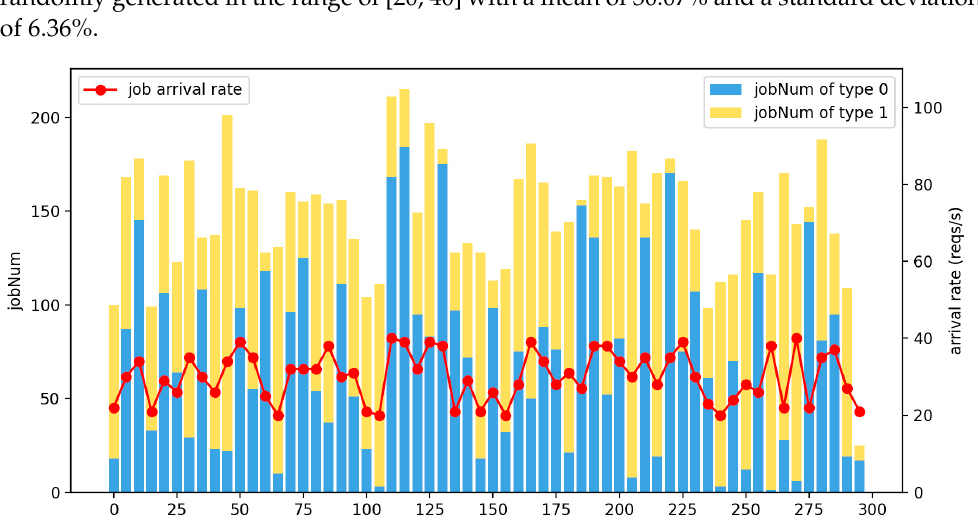
Figure 9. Average response time in low-frequency workload mode. Figure 10. QoS satisfaction in low-frequency workload mode.